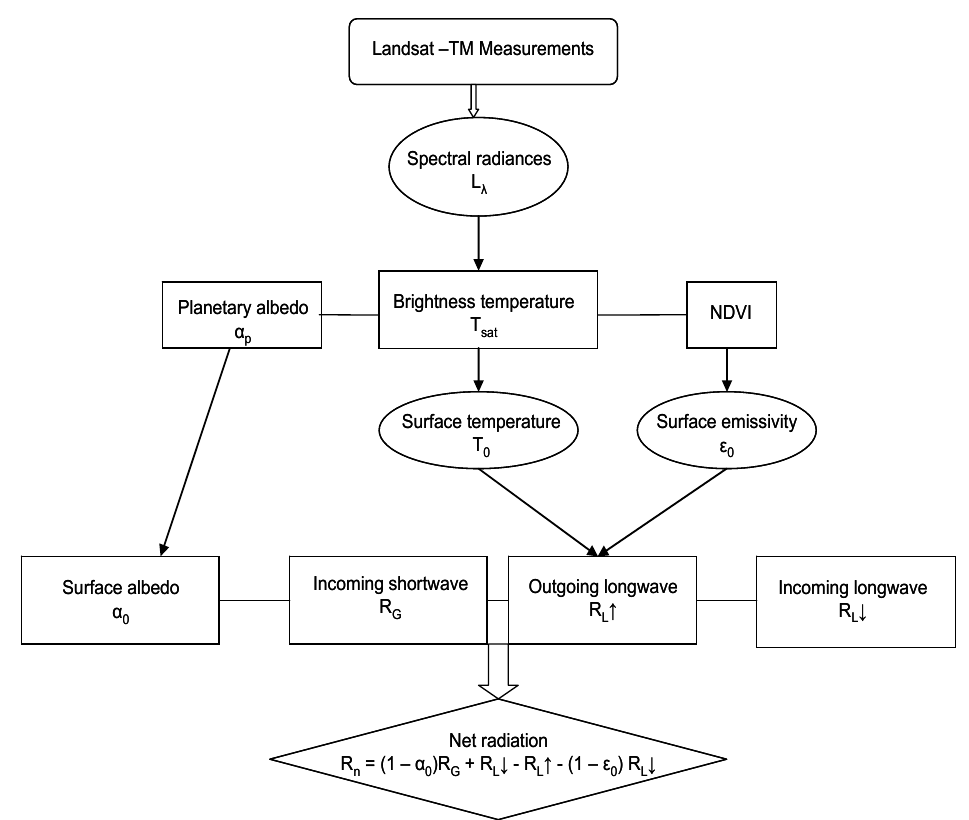
Figure 1. Schematic flowchart for the regional radiation balance for PM1